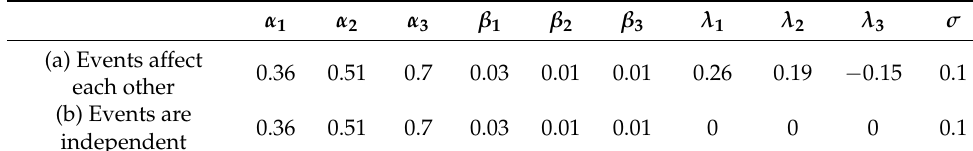
Table 4. Parameter settings under affected conditions and independent condition.